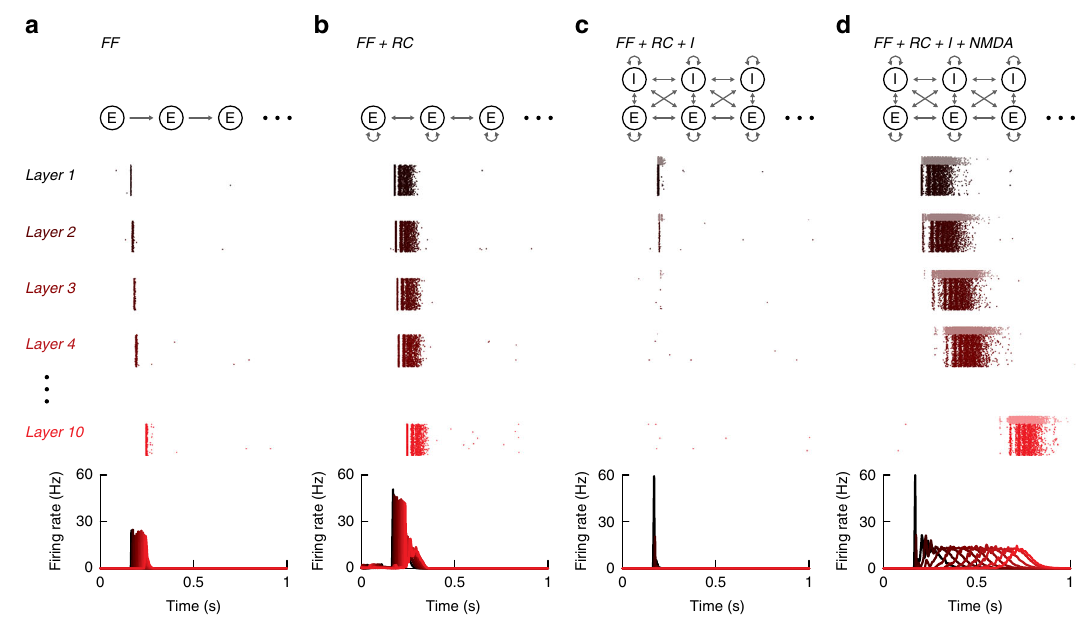
Fig. 8 Simulation of multilayer networks. a Dot rasters of spikes showing simulations of a purely feedforward network composed of only excitatory neurons (480 neurons; see Methods for a detailed description of the network and parameters). All neurons of a single trial are shown in the dot raster (top) and 30 trials are compiled to plot the average fi ring rate (bottom). b Same network as in a but with additional recurrent connections between and within layers. c Same network as in b with inhibitory neurons (120 inhibitory neurons, i.e. 20%, presented as light dots in the spike raster). d Same network as in c but